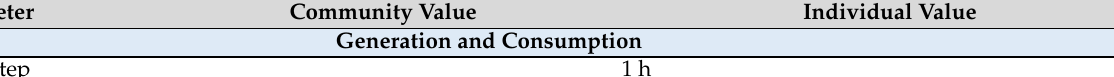
Table 4. Data employed in the simulation. Source: